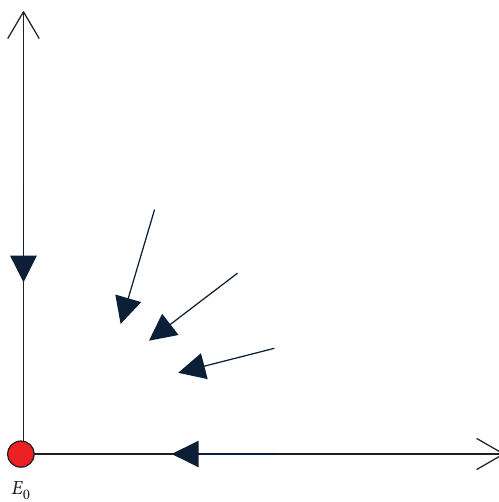
Figure 4: Visualization of Theorem 5 for 4 fc >